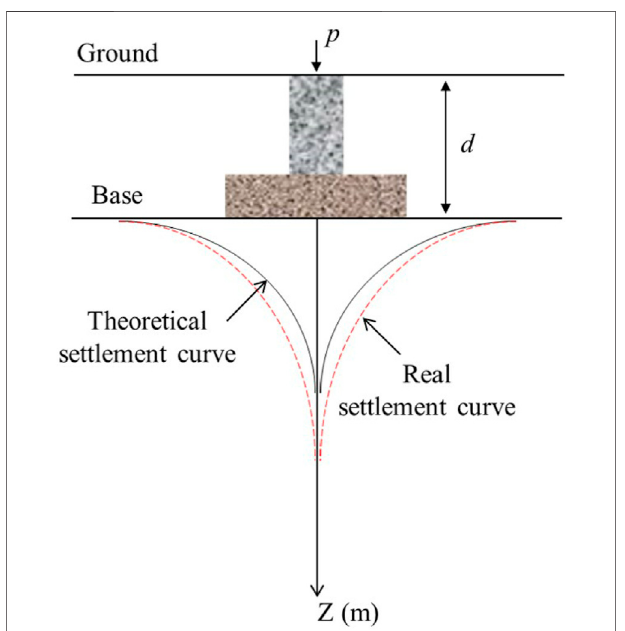
FIGURE 2 | Vertical diagram of the theoretical and actual